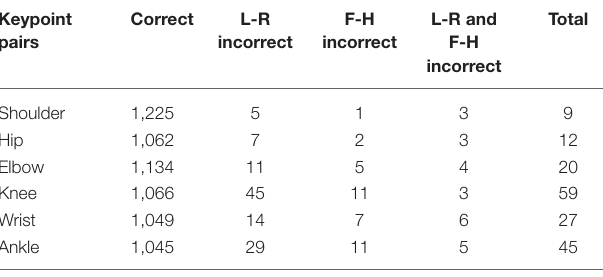
TABLE 2 | Number of the misattribution